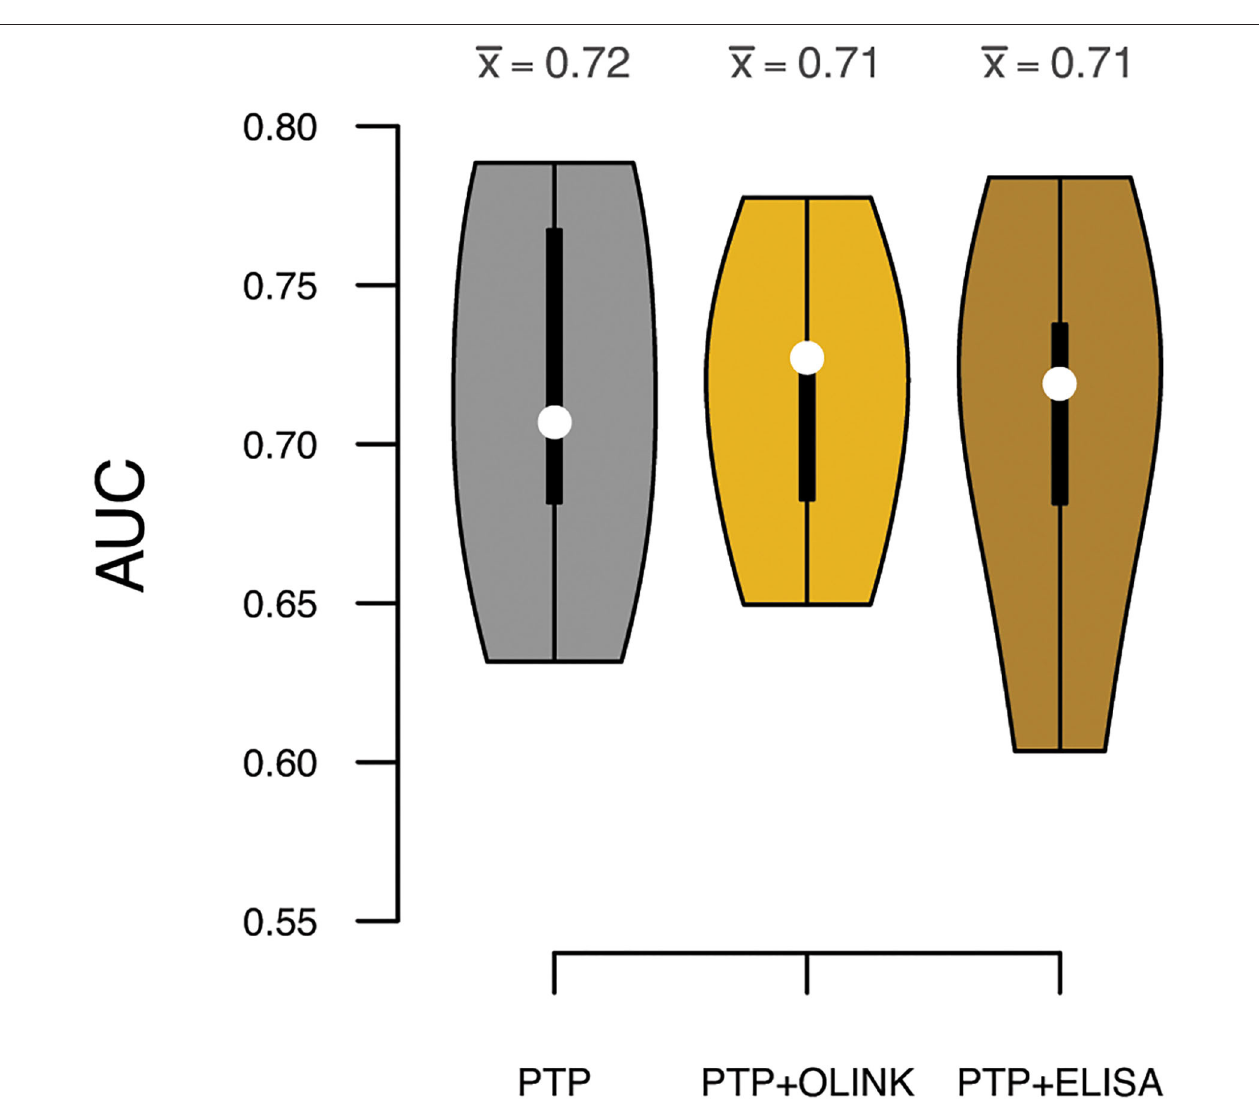
FIGURE 6 | Prediction accuracies measured by area under the receiver operating characteristic curve (AUC) for discrimination of obstructive CAD. White dots indicate median AUC across the five validation sets, and the mean AUC ( x ) for each model is indicated above each violin. Predictions were based on the pretest probability (PTP) with and without sortilin measurements by OLINK and